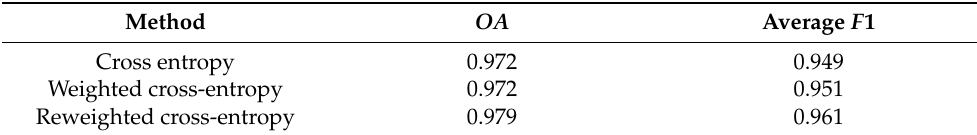
Table 7. Comparison of the different loss function.